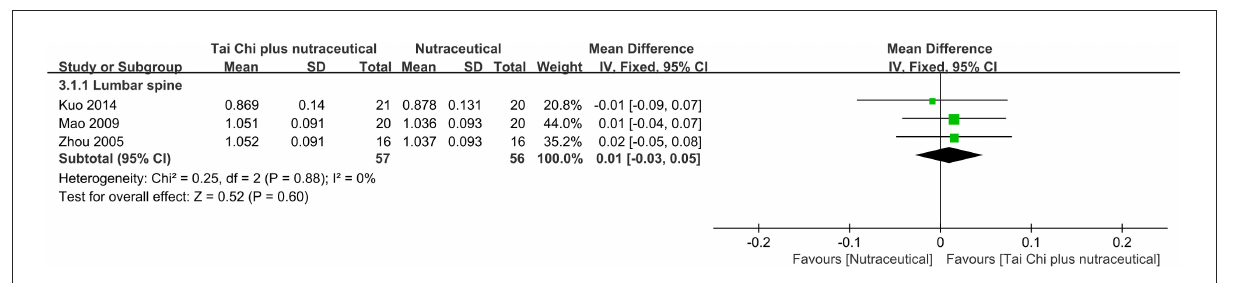
FIGURE5 Forest plot of meta-analysis results for Tai Chi plus nutraceutical vs.